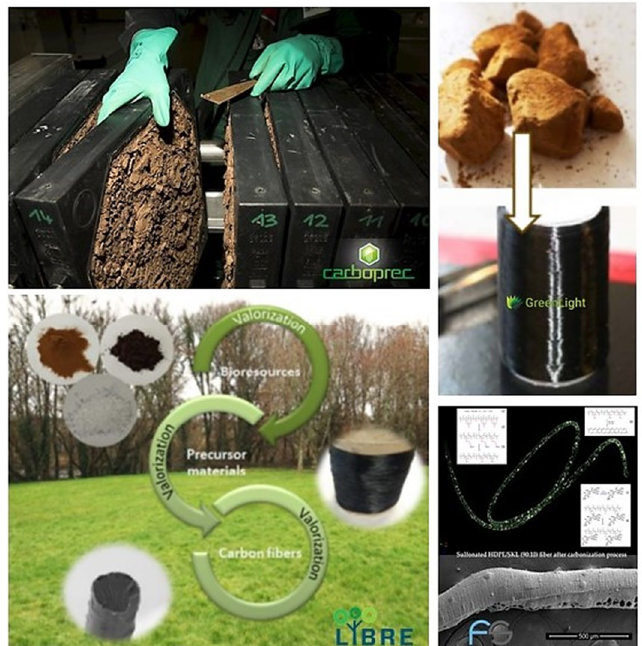
Figure 7. Use of alternative precursors for CFs with different scientific prioritization: (i) Functionalized tailored CFs based on textile-grade polyacrylonitrile (PAN), polyolefins, and lignins [95]; (ii) CFs based on polyethylene for cost efficiency [96]; (iii) cost efficient CFs based on cellulose and lignin [97]; (iv) reduction of energy and greenhouse gases in the CF manufacturing process by using the LignoBoost technology [98,99]; and (v) biobased composites based on lignin precursors and biopolymers [100,101].